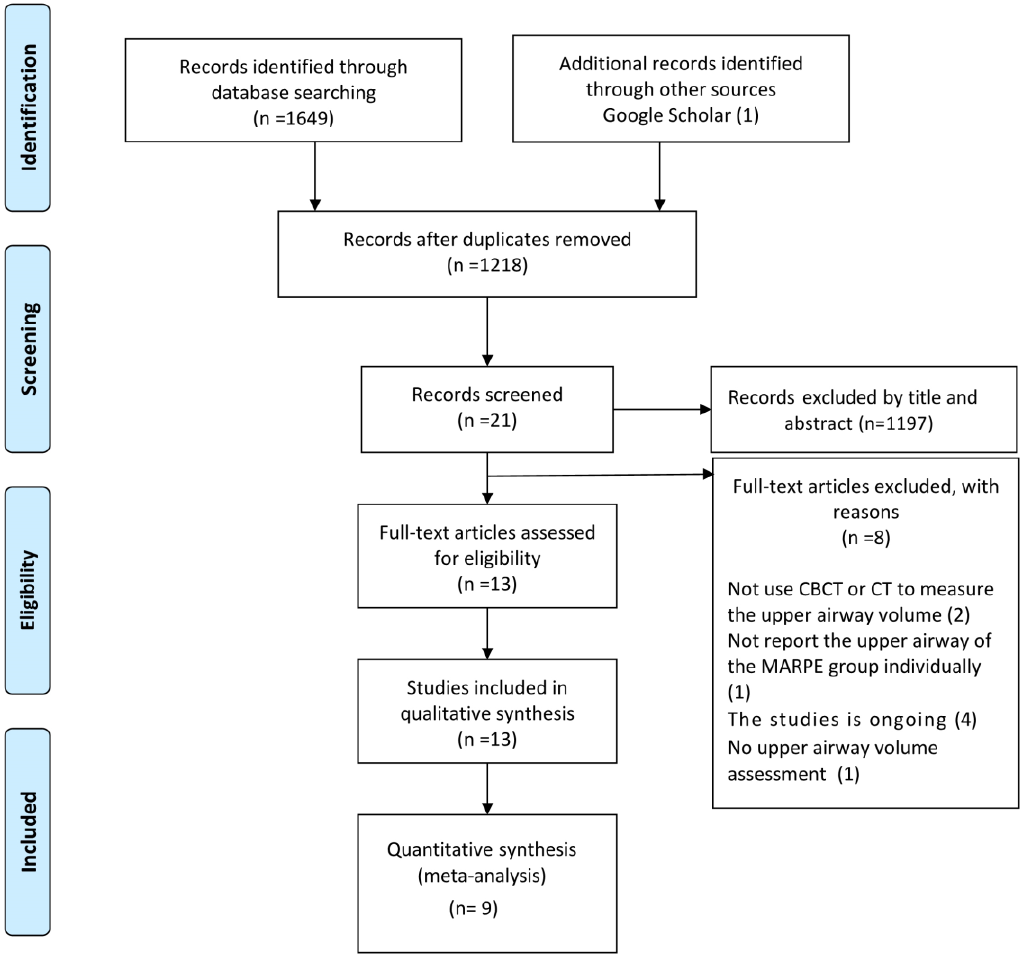
Figure 1. The flow diagram of the study selection process.